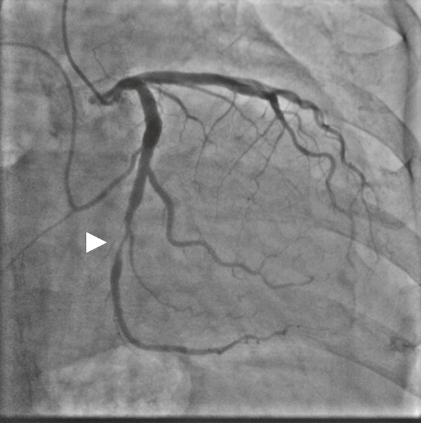
Figure 1: Baseline coronary angiography showed severe luminal stenosis of the mid left circumflex artery (head arrow).